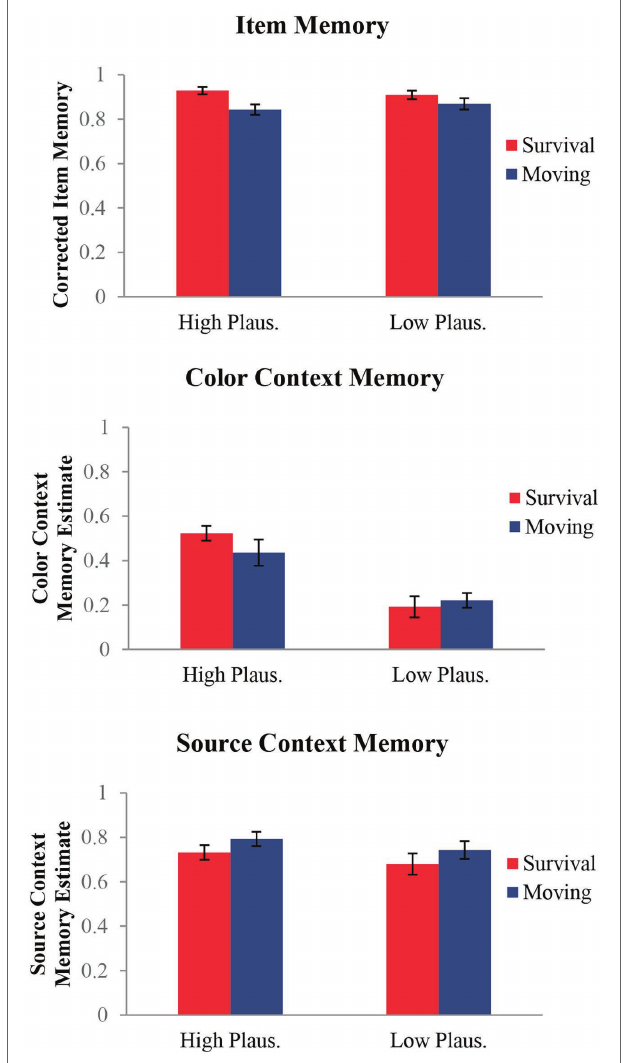
FIGURE 2 | Measures of memory for item and both context details (color and source) as functions of condition and plausibility. Results indicated a survival processing effect for item memory consistent with prior work. For color context, results showed a plausibility by condition interaction driven by better memory for highly plausible colored items in the survival processing condition. There were no effects for source